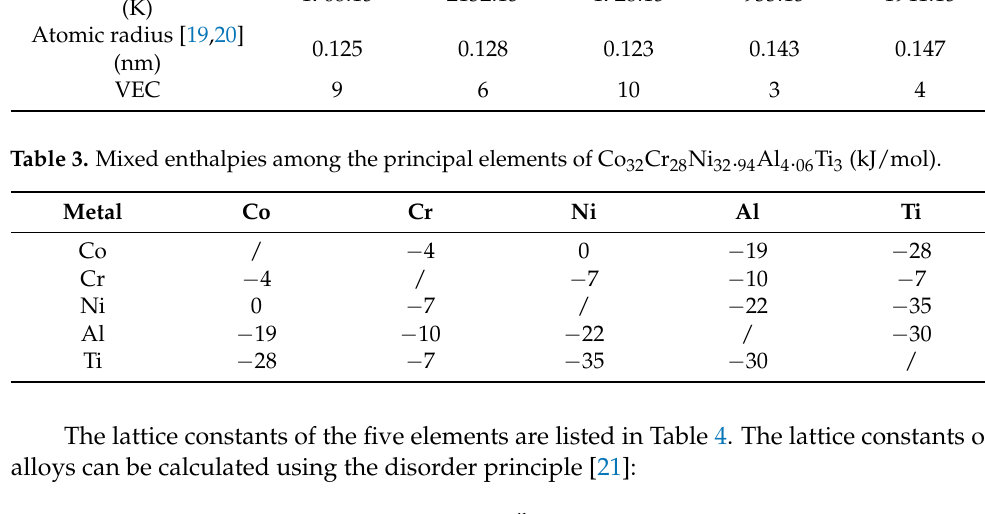
Table 2. Characteristic parameters of the principal elements of Co 32 Cr 28 Ni 32 . 94 Al 4 . 06 Ti 3 . Metal Co Cr Melting point